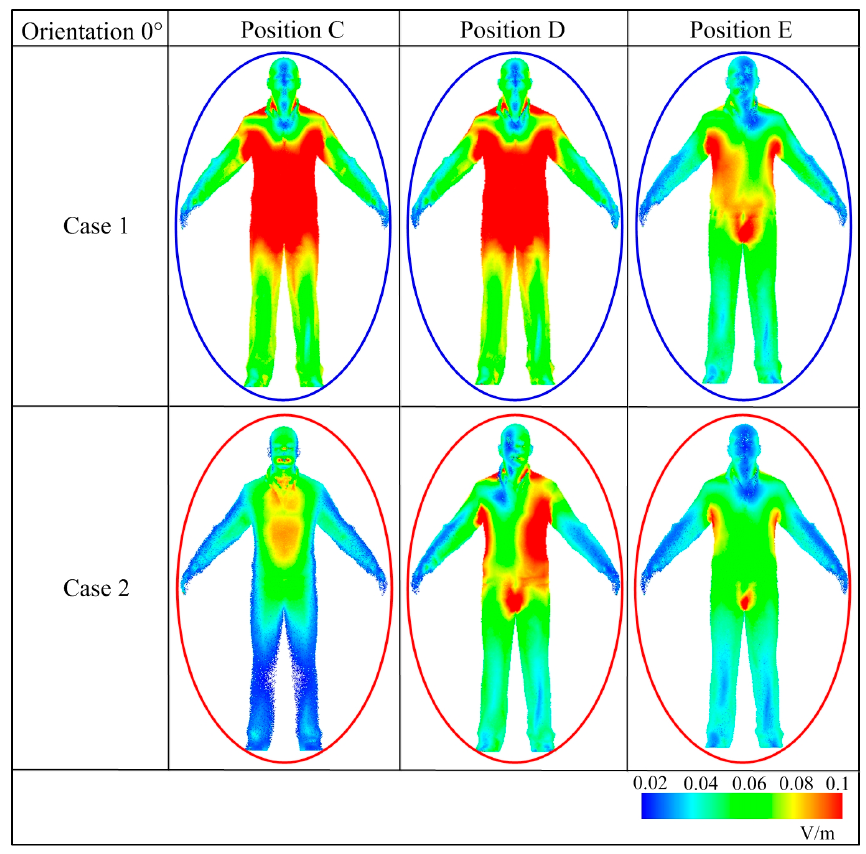
Figure 10. The induced electric field in a standing human body at positions C, D, and E.